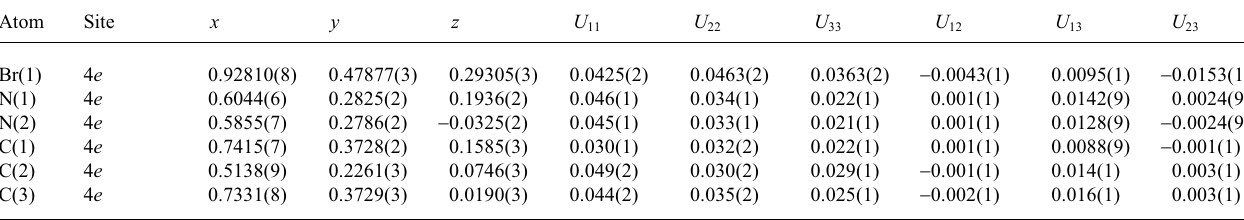
Table 3. Atomic coordinates and displacement parameters (in Å 2 )